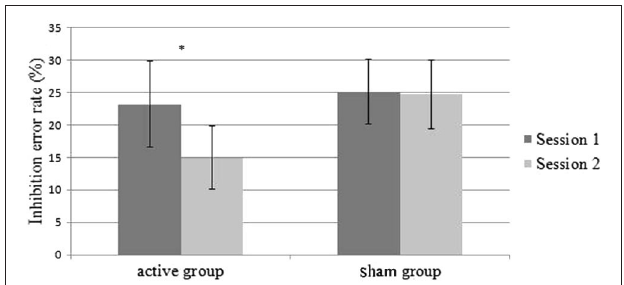
FIGURE 3 | Mean inhibition error rates on the AS task as a function of the sessions (session 1 vs. session 2) and group (active vs. sham) . Errors bars represent standard error.